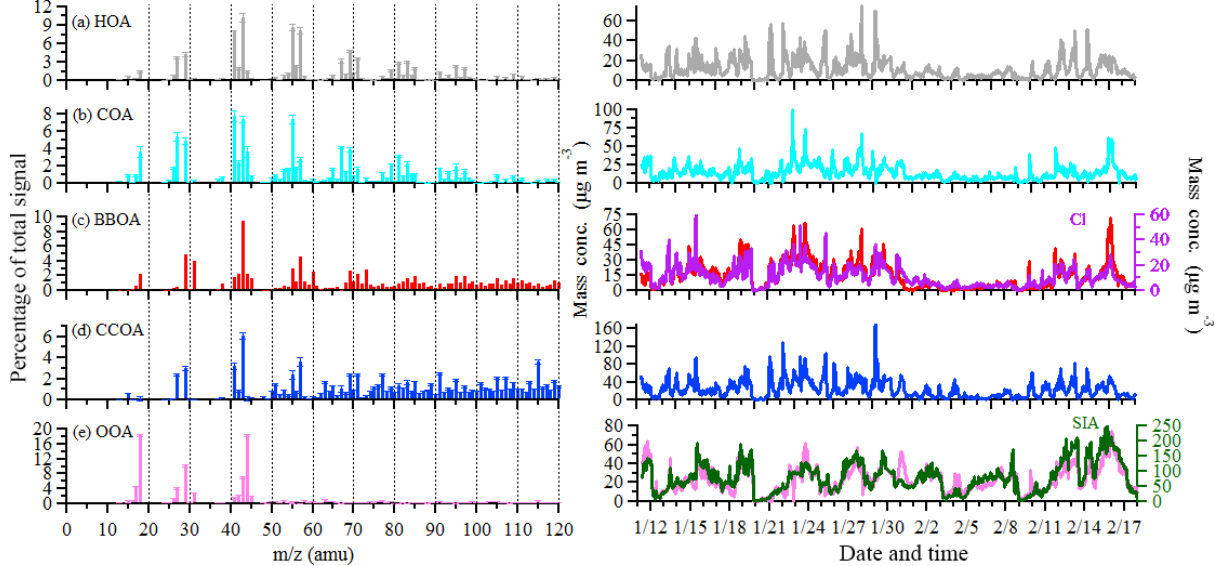
Figure 3. Mass spectrums (left) and time series (right) of five OA sources. Error bars of the mass spectrums represent the standard deviation of each m/z over all accepted